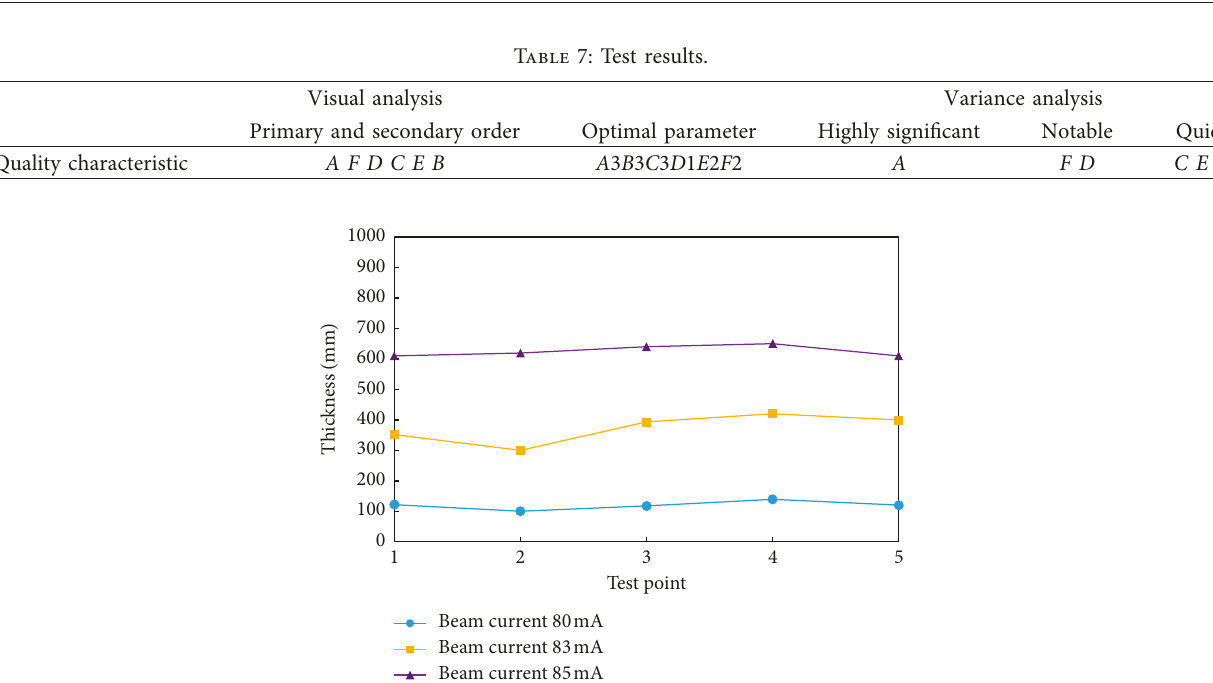
Figure 2: Thickness of the coating with different beam current.